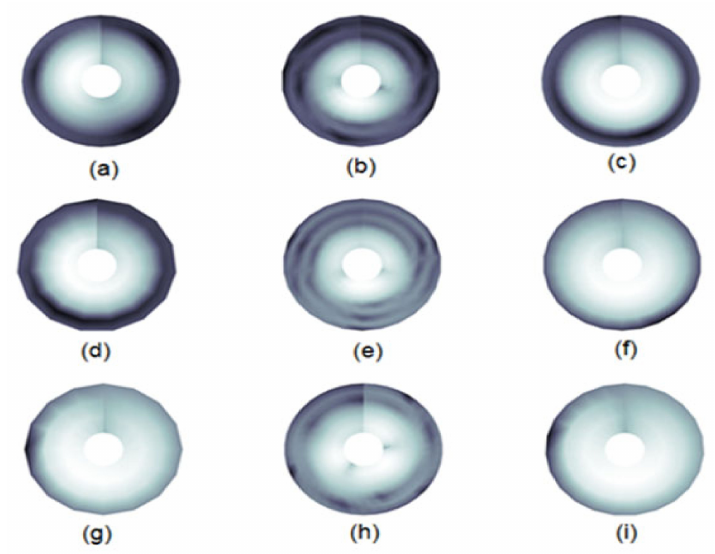
Figure 7. The irisgrams for ECG types: ( a ) The Normal P-wave irisgram; ( b ) The Normal QRS-waves irisgram; ( c ) The Normal T-wave irisgram; ( d ) The Bradycardia P-wave irisgram; ( e ) The Bradycardia QRS-waves irisgram; ( f ) The Bradycardia T-wave irisgram; ( g ) The Tachycardia P-wave irisgram; ( h ) The Tachycardia QRS-waves irisgram; ( i ) The Tachycardia T-wave irisgram.